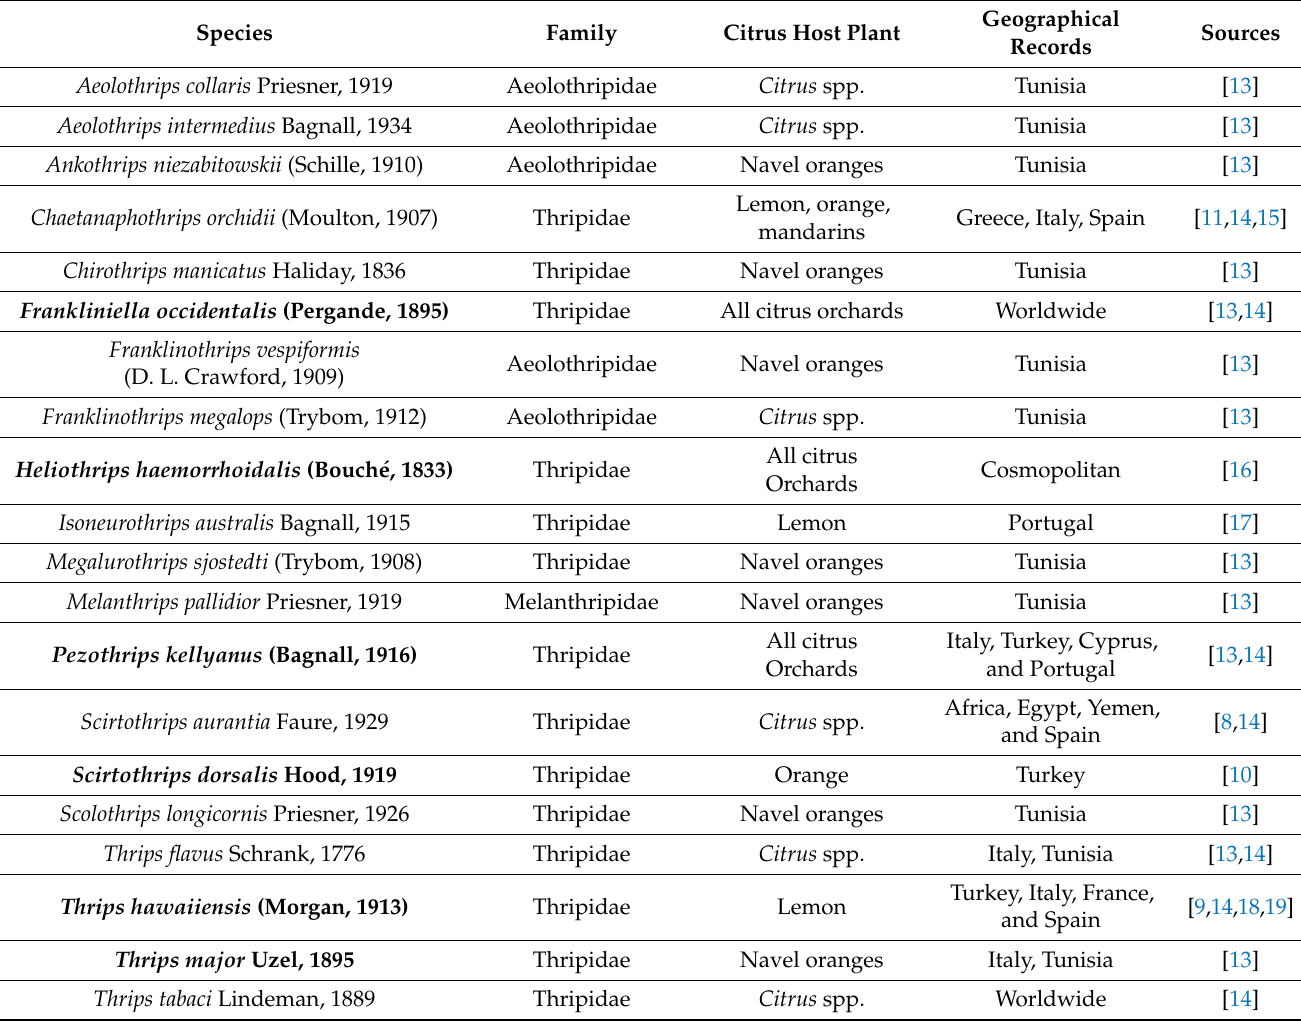
Table 1. Citrus thrips species and Mediterranean geographical distribution. The species marked in bold are considered the most common in the Mediterranean